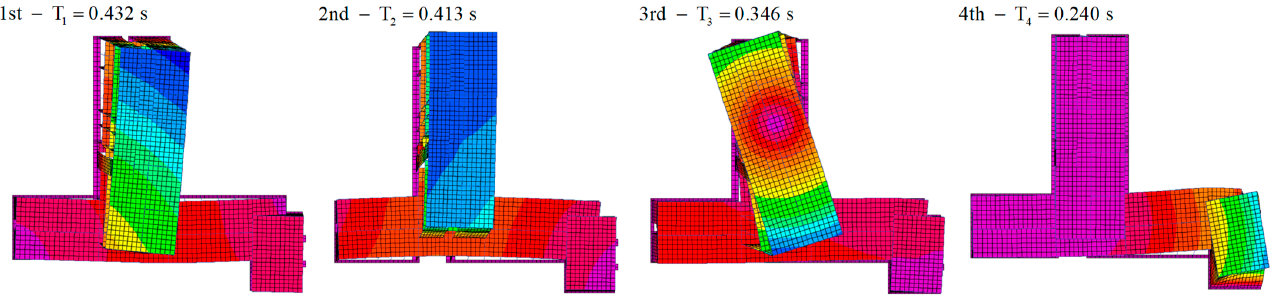
Figure 13. Eigenmodes and corresponding periods values for the as-built state of the building. Figure 14. Eigenmodes and corresponding periods values for cracked sections of the as-built state of the building. the